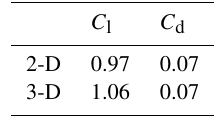
Table 2. C l and C d for the simulated 2-D airfoil and 3-D blade at r = 0 . 26 R , AoA ≈ 13 ◦